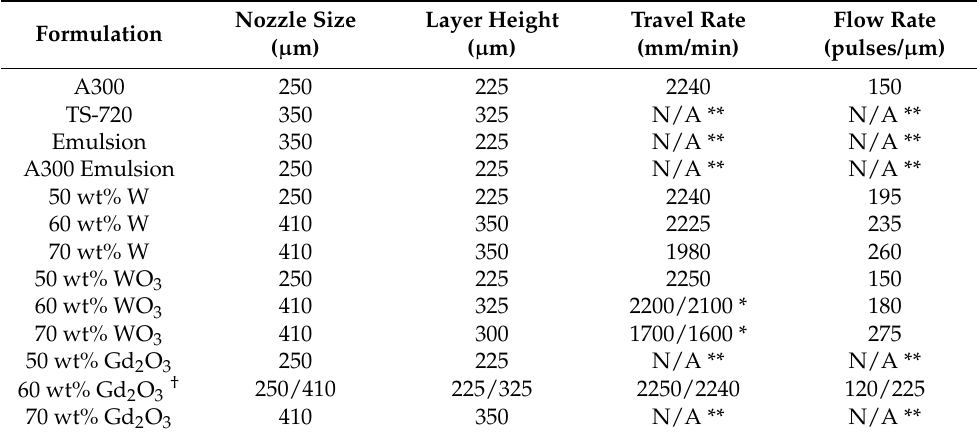
Table 2. Print settings for ink formulations used in this study.